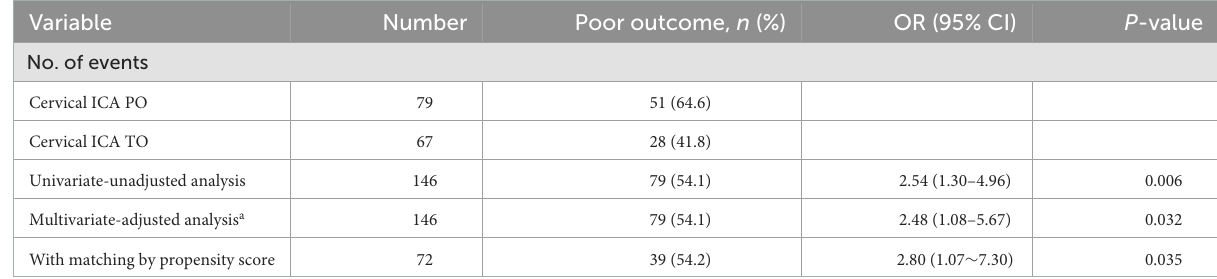
TABLE 3 Associations between the cervical ICA PO (vs. TO) and clinical outcome in the univariate-unadjusted analysis, multivariate-adjusted analysis, and propensity score analyses. Variable